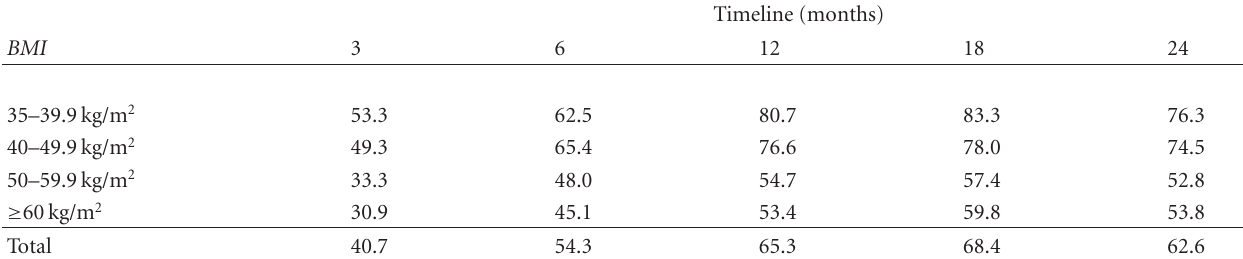
Table 6: %EWL of patients without a second operation during the follow-up period ( n =